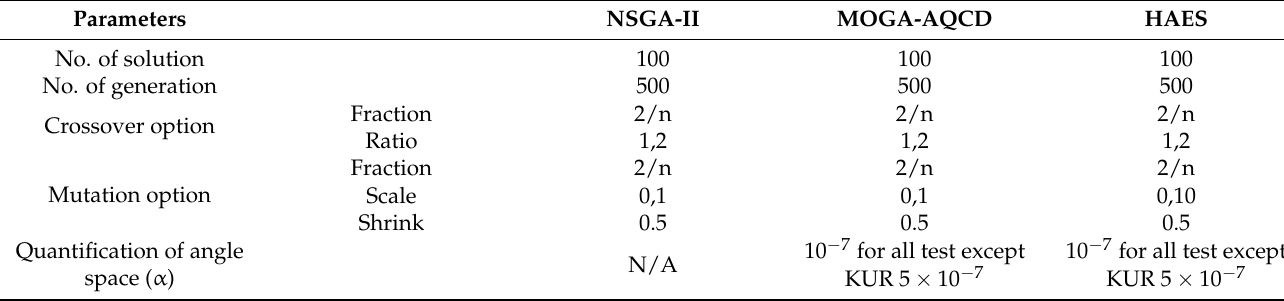
Table 4. Parameters of NSGA-II, MOGA-AQCD, and HAES.